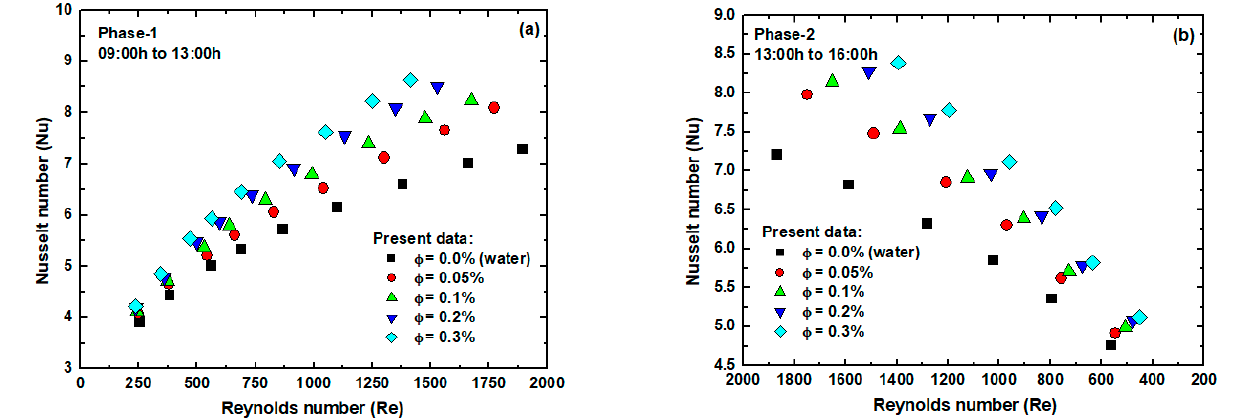
Figure 11. The hybrid nanofluids Nusselt number; Phase-1 ( a ), and Phase-2 ( b ).